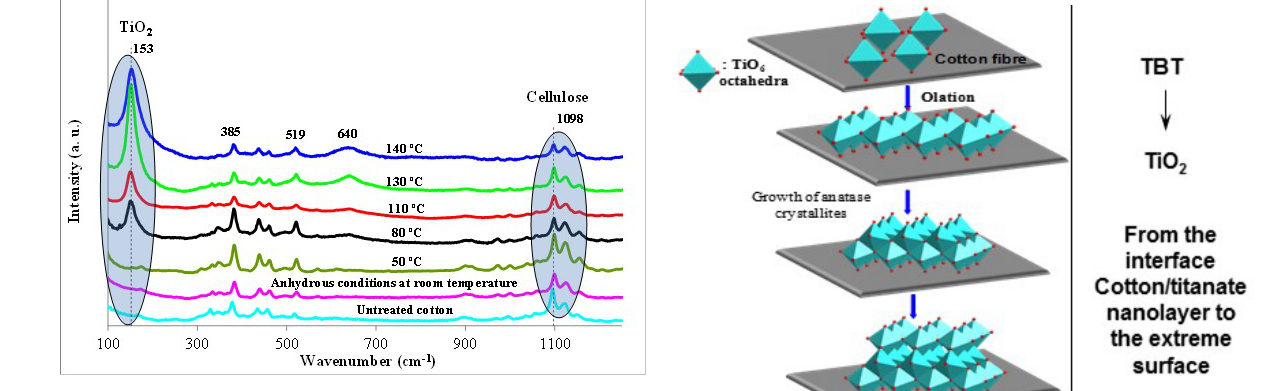
Figure 1: Raman spectra of cotton-TiO 2 samples showing the evolu- tion of the characteristic peak of anatase (at 153 cm −1 ) as a function of the hydrothermal treatment temperature; cellulose peaks are lo- cated around 1098 cm −1 [24]; reprinted (modified) with permission from Royal Society of Chemistry